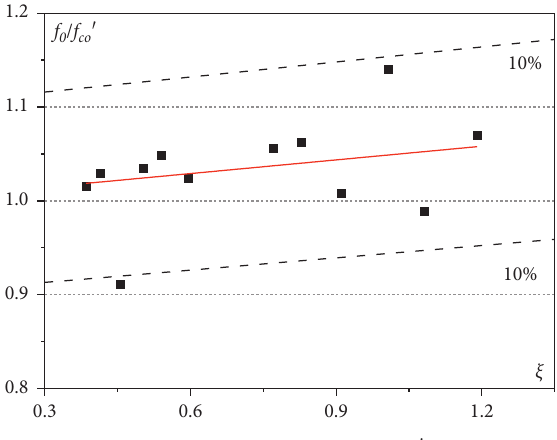
Figure 10: Relationship between f